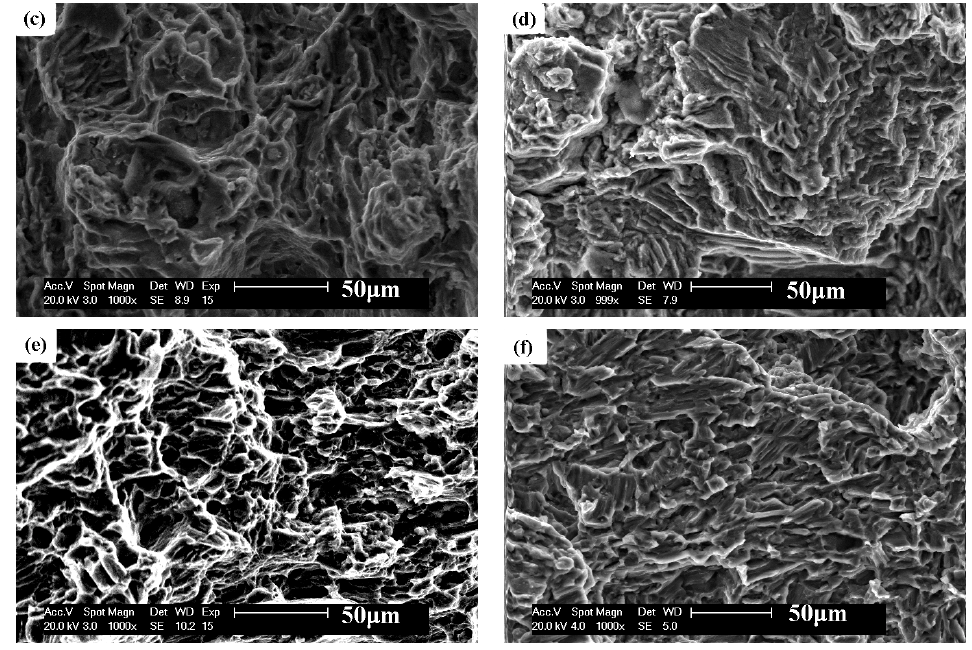
Figure 6. SEM fractography of the SSRT test samples ( a ) 1# in air, ( b ) 1# in DW, ( c ) 2# in DW, ( d ) 3# in DW, ( e ) 4# in air and ( f ) 4# in DW.